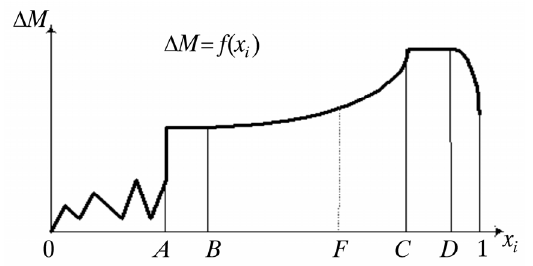
Fig 2. Dependence of the additional profit margin gain -th channel on changes of transportation volumes in i of logistic system Movement on an abscissa axis from up to 0 = x i is the process of accustoming channel to Ax the i = the passing of the given freight traffic. Small vol- umes of transported production on this section cause absence of constant loading and incidental work with different financial